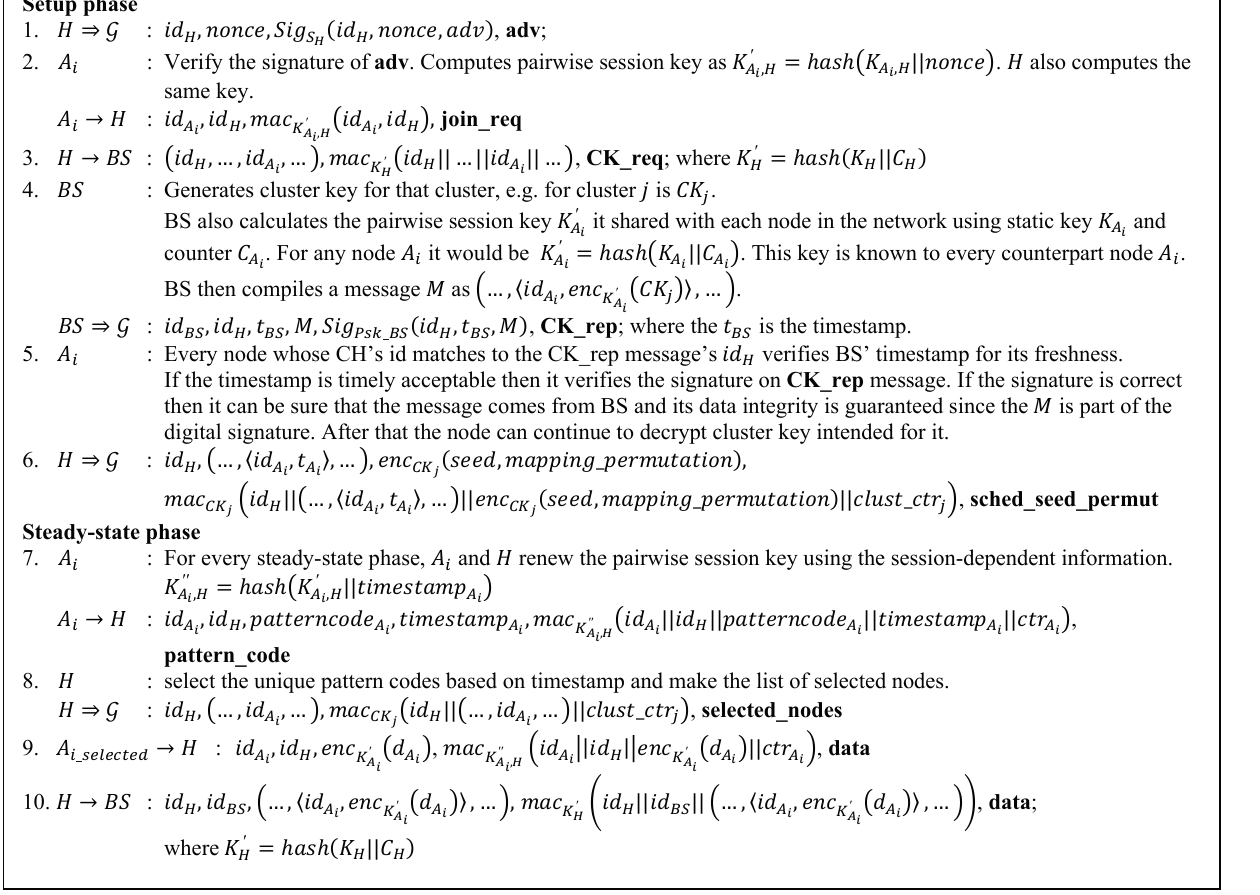
Figure 7. The proposed